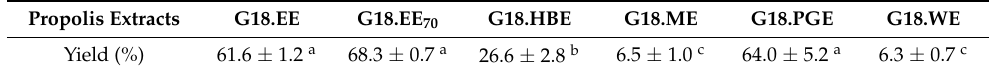
Table 1. Yields (%) resulting from the extraction of G18 with different solvents—absolute ethanol (G18.EE), ethanol/water (7:3) (G18.EE 70 ), honey brandy (G18.HBE), mead (G18.ME), propylene glycol (G18.PGE) and water (G18.WE)—expressed as a mean and respective standard deviation (SD). Statistical analysis was performed by one-way ANOVA followed by Tukey’s test for multiple comparisons. Mean values with the same letters (a, b or c) are not statistically